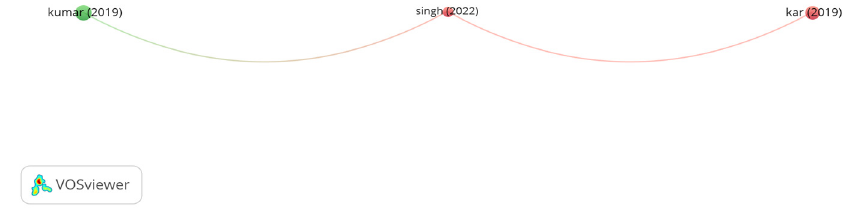
Figure 16. Network visualization of sisal fibers.